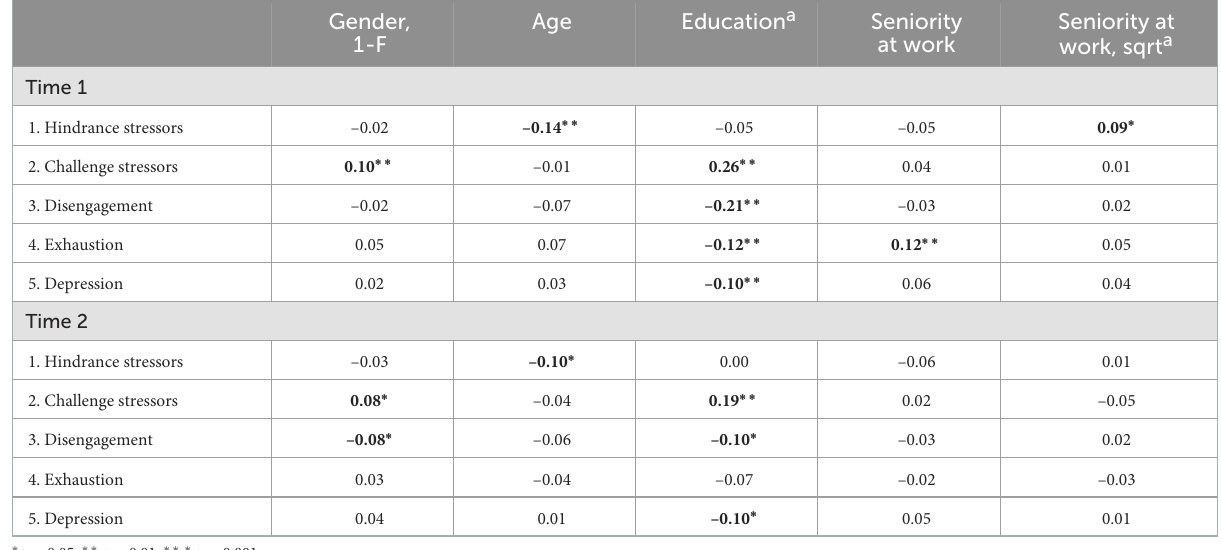
TABLE A1 Zero-order correlational coefficients for study variables and sociodemographic characteristics separately for measurement